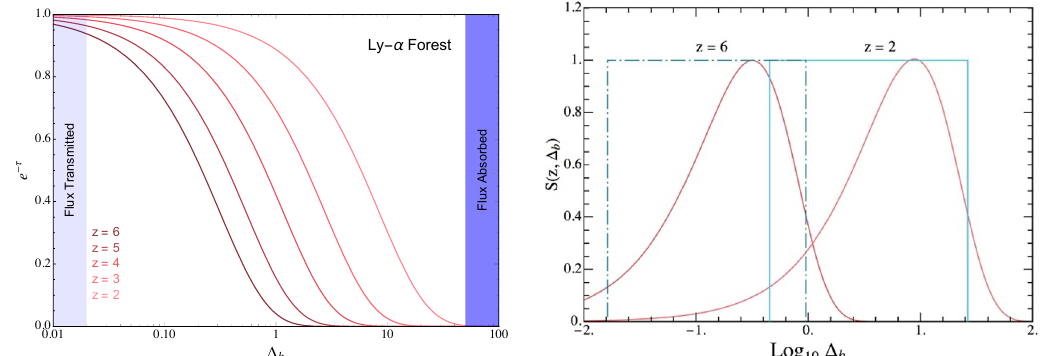
Figure 3 . Left: absorption probability of Ly- (cid:11) forest (cid:13)ux as computed in ref. [64]. Here, we have taken the redshift dependence of T 0 and (cid:13) , de(cid:12)ned as T ((cid:1) b ) (cid:17) T 0 (cid:1) (cid:13) (cid:0) 1 measurements in ref. [63] to normalize the optical depth at each redshift. Right: adopted Ly- (cid:11) sensitivity functions S ((cid:1) b ; z ) from eq. (3.2) (blue) and eq. (3.3) (red) for z = 2 and z =